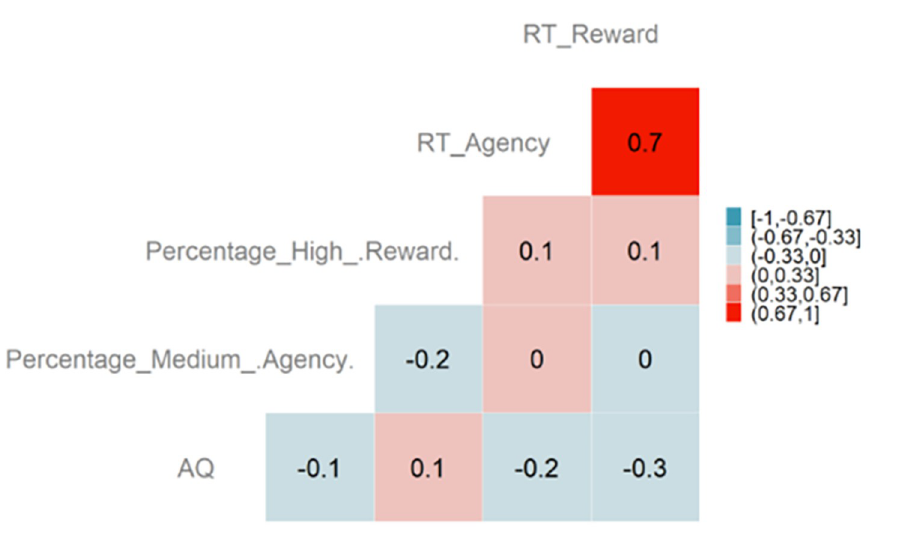
Fig 6. Correlations with autistic traits. n = 42.